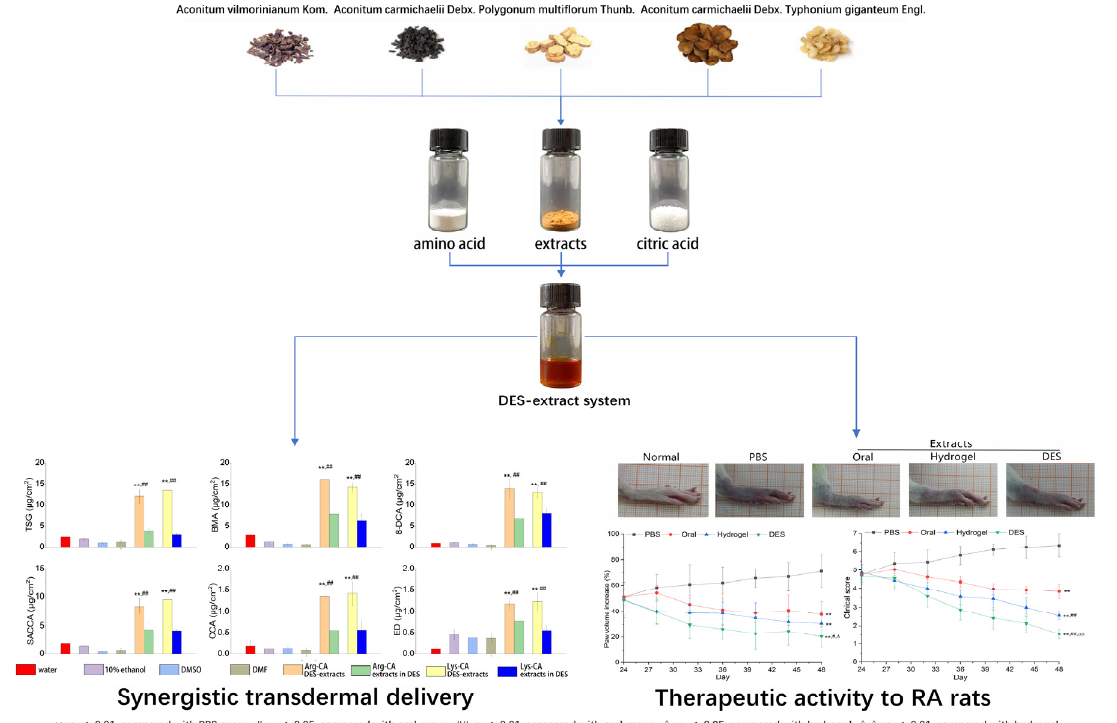
Figure 2. The treatment of arthritis with the active ingredients of “sanwujiaowan” extract through the deep eutectic solvent–hydrogel system. the deep eutectic solvent–hydrogel